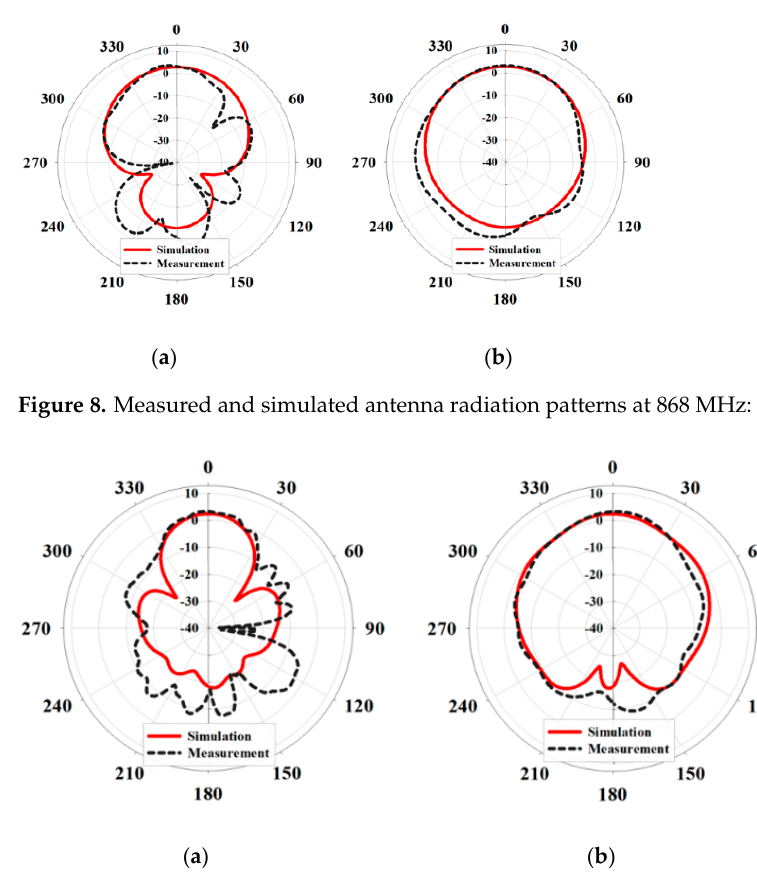
Figure 9. Measured and simulated antenna radiation patterns at 2.44 GHz: ( a ) E-plane; ( b ) H-plane. Table 2. Comparison of Dual-Band Wearable Antennas.